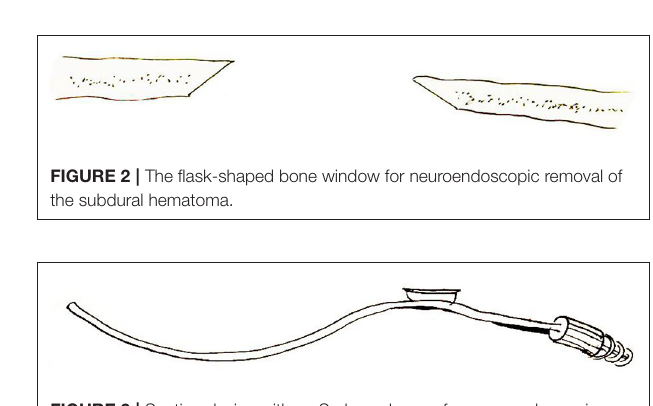
FIGURE 3 | Suction device with an S-shaped curve for neuroendoscopic removal of the subdural